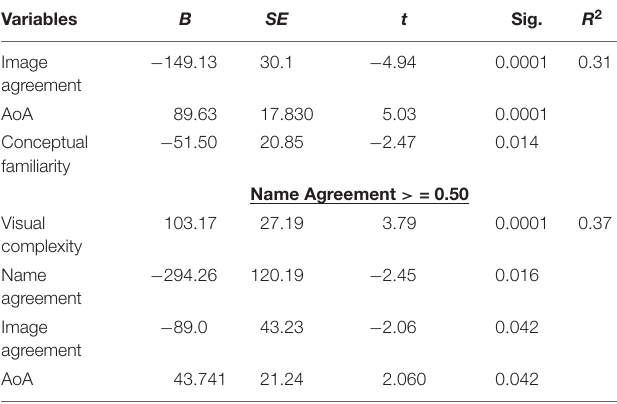
TABLE 3 | Step-wise regression with RT as a dependent variable.